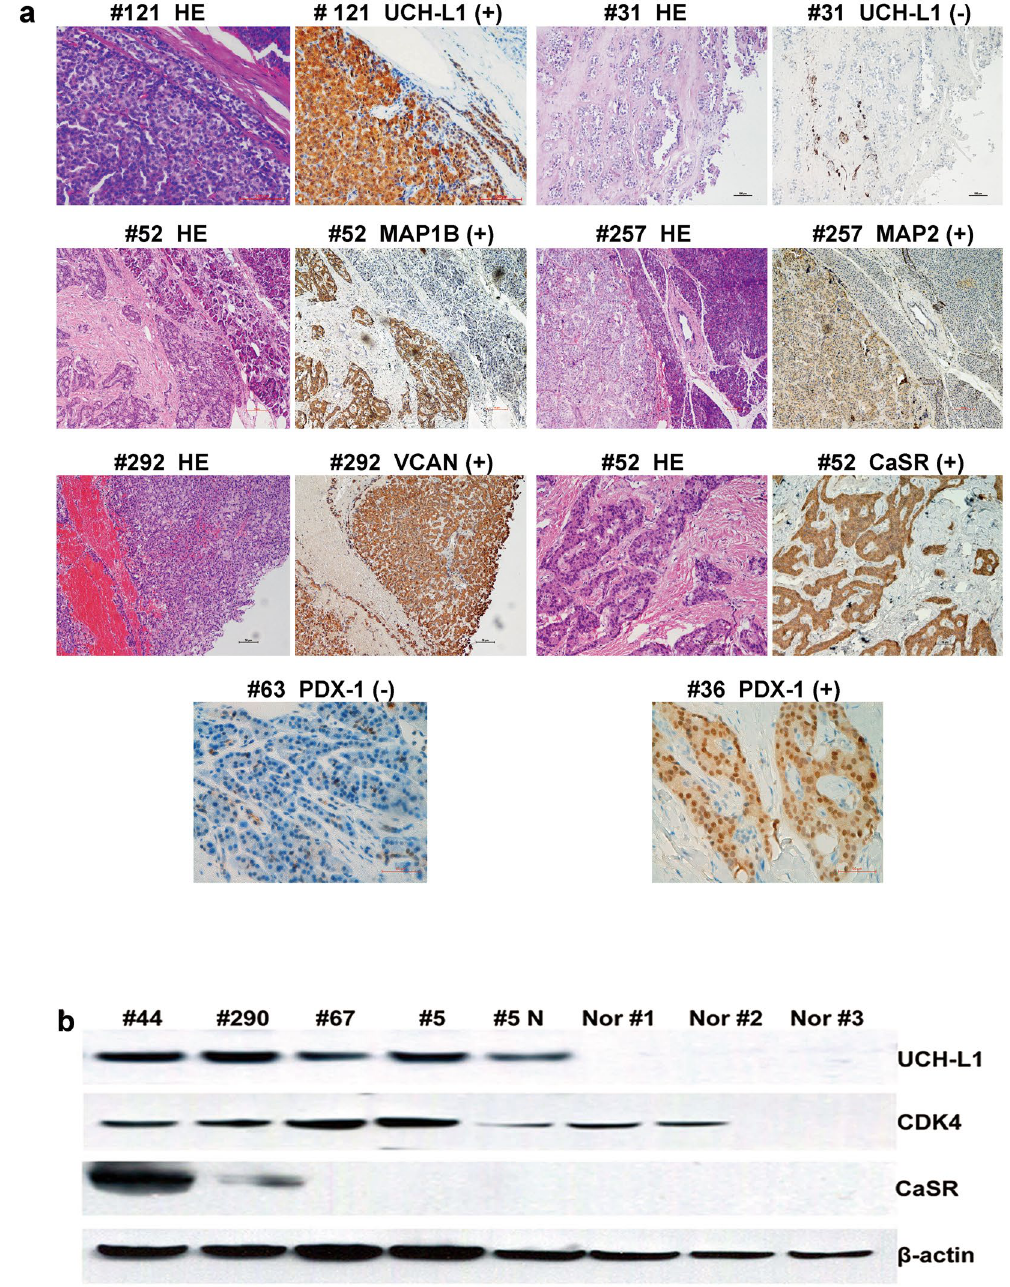
Figure 2. Representative examples of validated protein expression in PNETs and paired pancreatic specimens. Part a : IHC results. Left panel: HE staining of tumors and their paired pancreatic specimens; middle panel 1: expression of UCH-L1, MAP1B and VCAN in tumor #121, #52 (upper) and #292, respectively; middle panel 2: HE staining of tumors and their paired pancreatic specimens; right panel: negative expression of UCH-L1 in tumor #31 with a few positive cells, positive expression of MAP2 and CaSR in tumor #257 and #52, respectively; lower panel: expression of PDX-1 in insulinoma #36 and the negative expression of PDX-1 in tumor #63. Scale bar: 100 µ m. Part b : Western blot results. Upper panel: expression of UCHL-1 in 4 PNETs, reduced expression of UCH-L1 in para-tumour tissue (#5 N) and no expression of UCH-L1 in 3 normal pancreatic specimens; upper middle panel 1: expression of CDK4 in 4 PNETs, 1 para-tumor tissue (#5 N) and 2 normal pancreatic specimens, no expression of CDK4 in 1 normal pancreatic specimen (Nor #3); lower middle panel 2: expression of CaSR in 2 PNETs and no expression of CaSR in 2 PNETs, para-tumor tissue (#5 N) and 3 normal pancreatic specimens; lower panel: β -actin was used as internal control. The identification of tumor was shown in